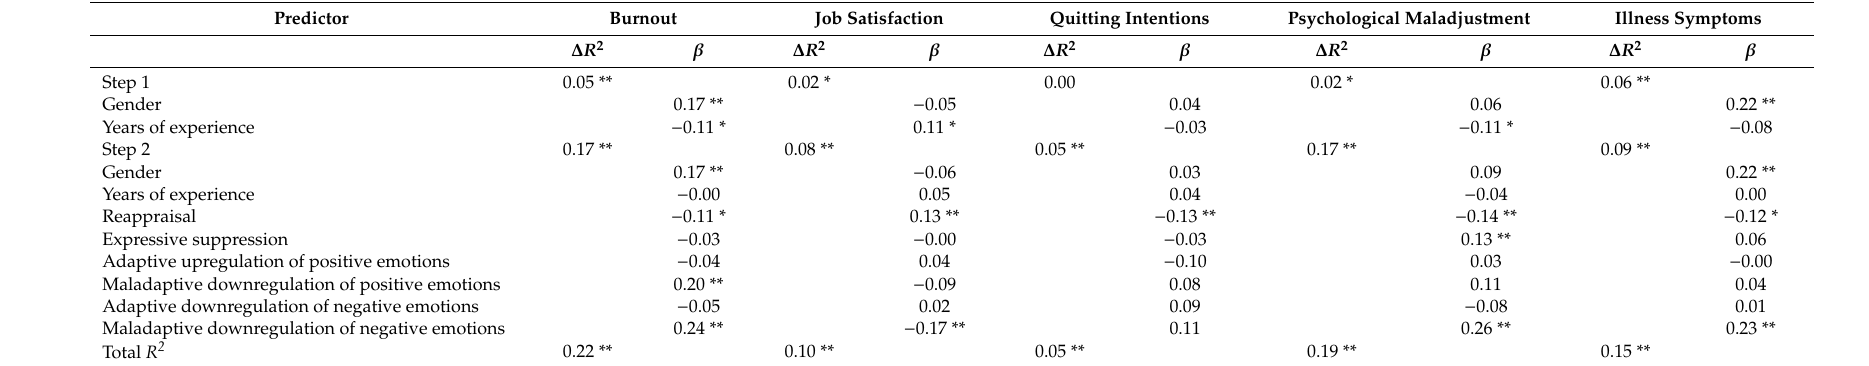
Table 4. Hierarchical multiple Regression